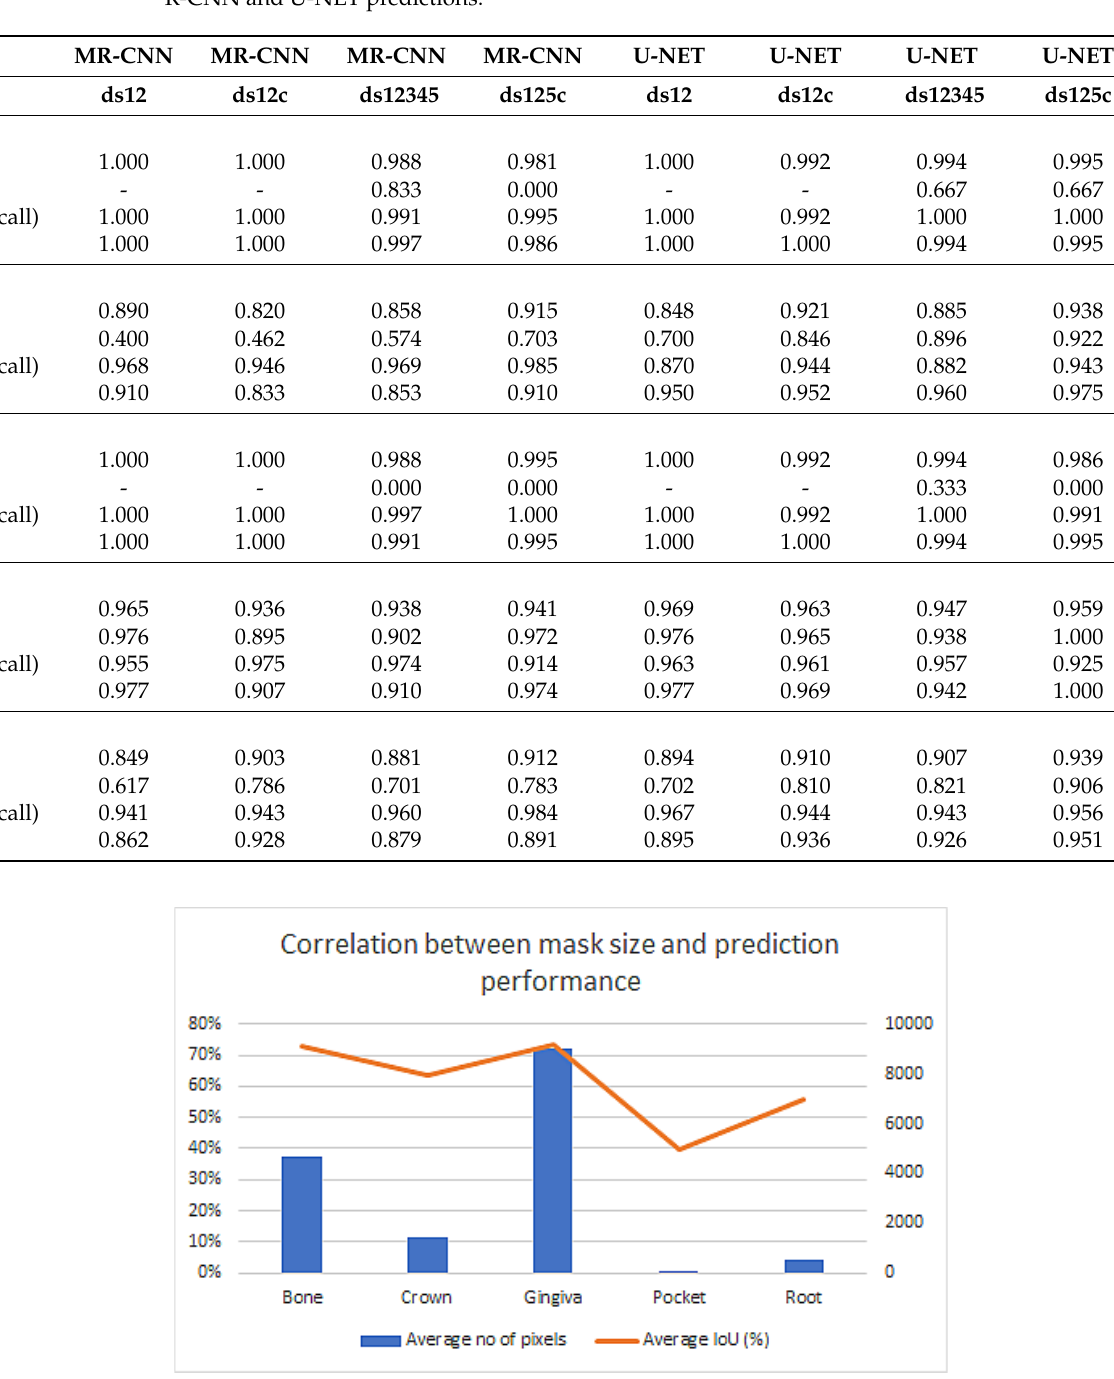
Table 1. Accuracy, specificity, and sensitivity for the corrected and uncorrected datasets for Mask R-CNN and U-NET predictions.